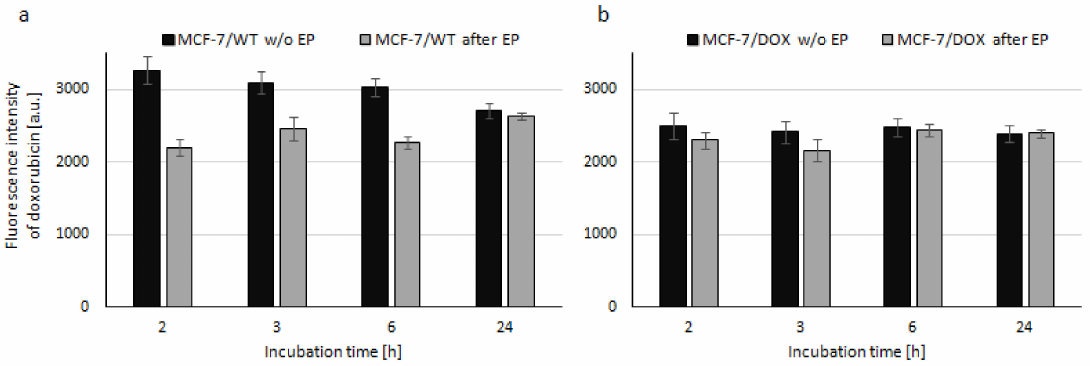
Figure 5. Relative fluorescence of doxorubicin in the supernatant of the ( a ) MCF-7 / WT and ( b ) MCF-7 / DOX cells without and after the application of electrical